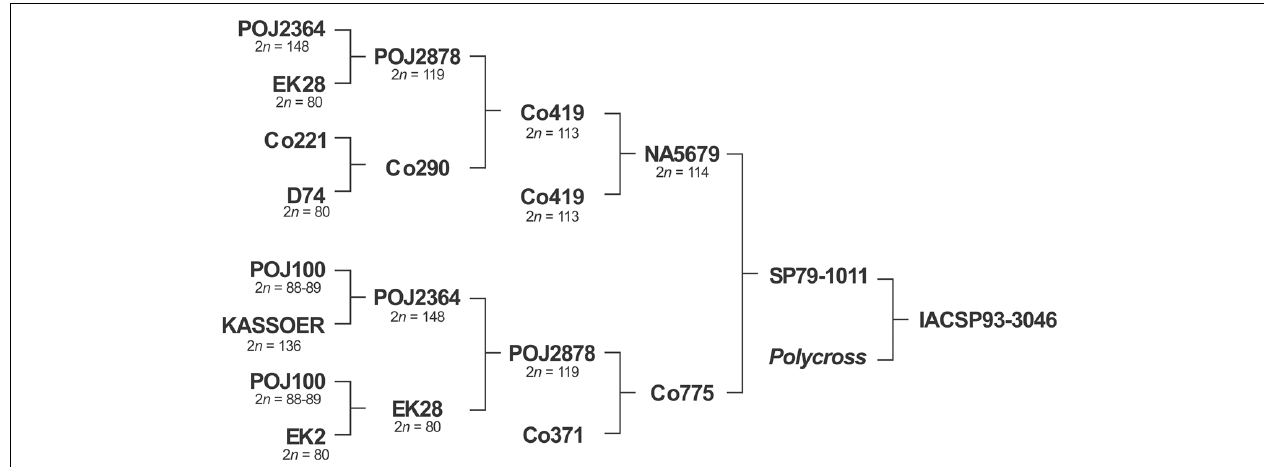
FIGURE 1 | The pedigree of the Brazilian sugarcane variety, IACSP93-3046. Kassoer, a spontaneous hybrid between Javanese Saccharum officinarum ( 2n = 80) and S. spontaneum ( 2n = 112, the wild Glagah); EK2 and EK28, S. officinarum clones cultivated by the natives in Java, Indonesia; D74, a Saccharum hybrid; POJ100, S. officinarum hybrid, a noble cane; POJ’s, Saccharum hybrids obtained on Java Island (robust canes, immune to sereh disease); Co, early cultivars improved in Coimbatore, India. Note that POJ2878 can be found in the pedigrees of almost all the dominant varieties grown worldwide, and many countries with breeding programs of their own continue to rely on Co clones as a germplasm base. NA, varieties bred in Argentina; SP and IAC, in Brazil. Chromosome numbers taken from the